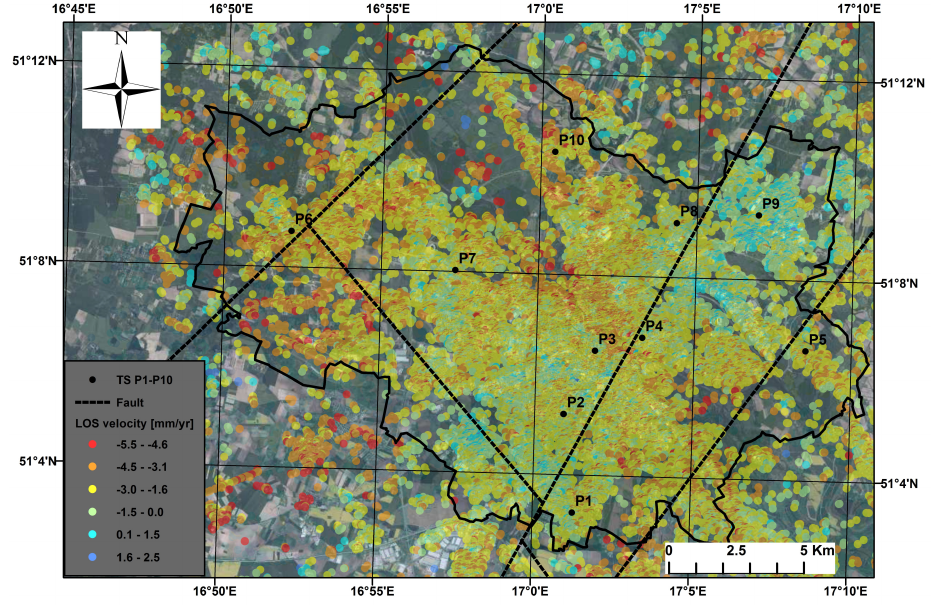
Figure 7. LOS velocities determined on the basis of Envisat data for the period 2002–2008. For the Sentinel-1A SAR stack in the period 2014–2018, the average LOS displacement velocities ranged from − 2.9 mm/year to +2.4 mm/year (Figure 8). Positive movements occurred in the southern and southwestern part, while the remaining area was subjected to negative